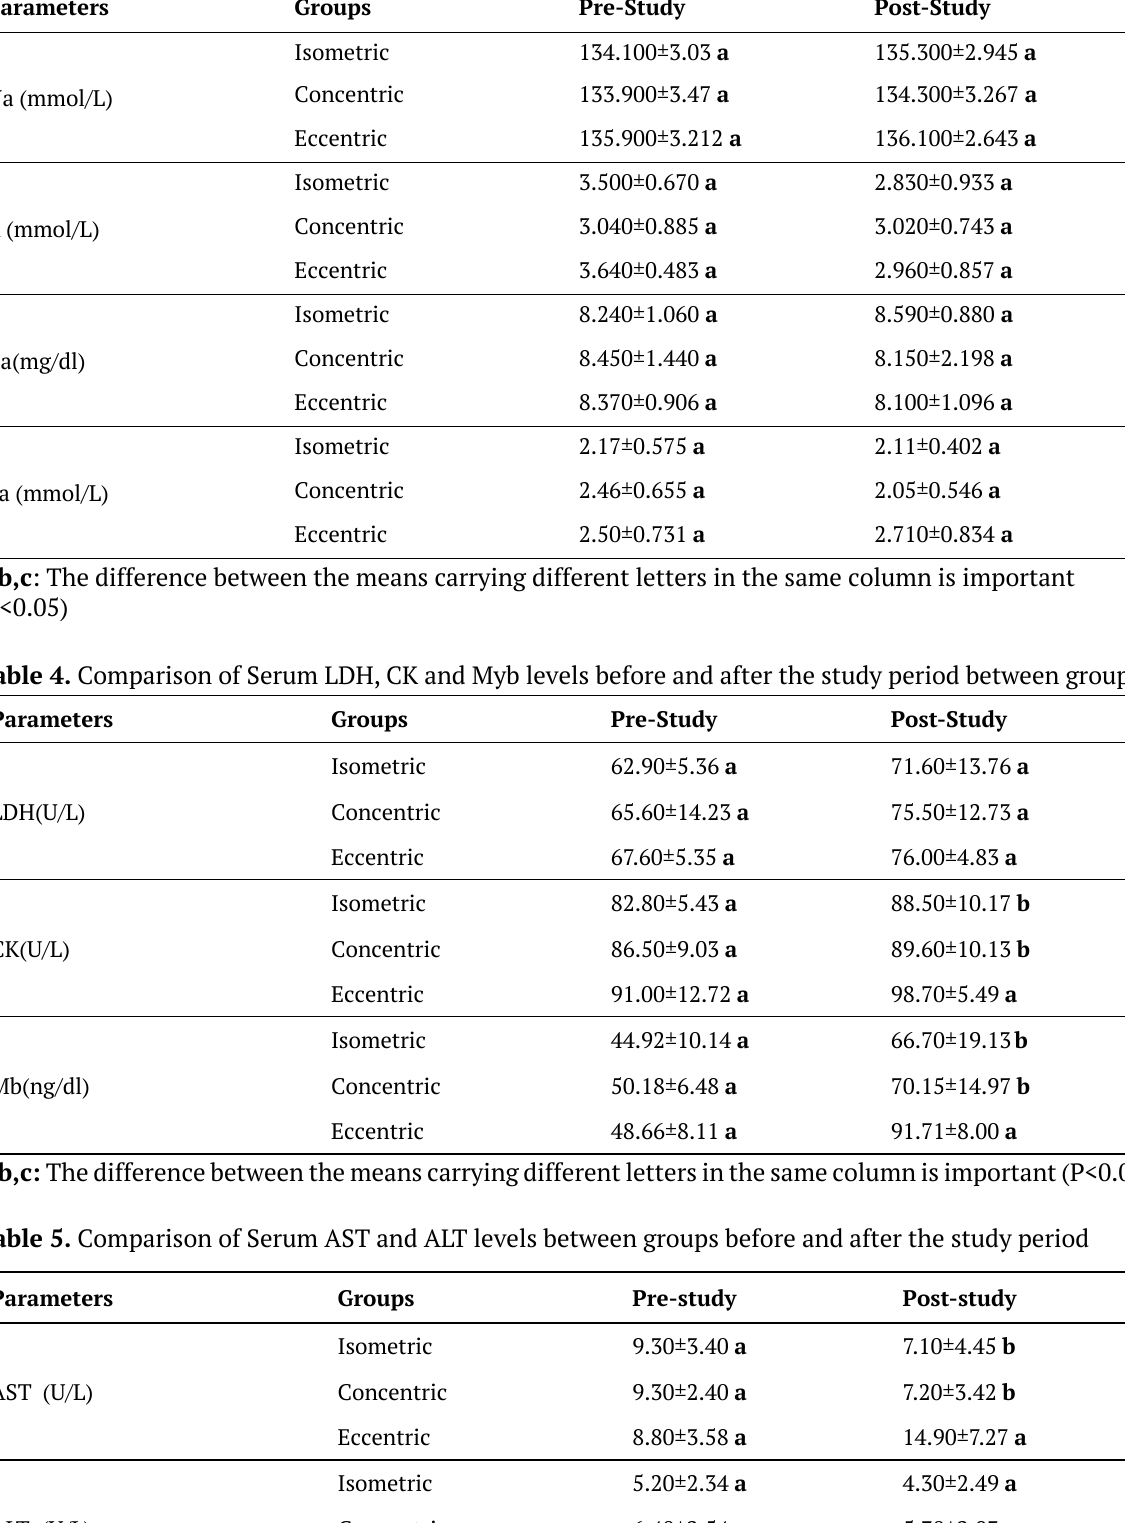
Table 3. Comparison of Serum Na, K, Ca and La levels between groups before and after the study period Parameters